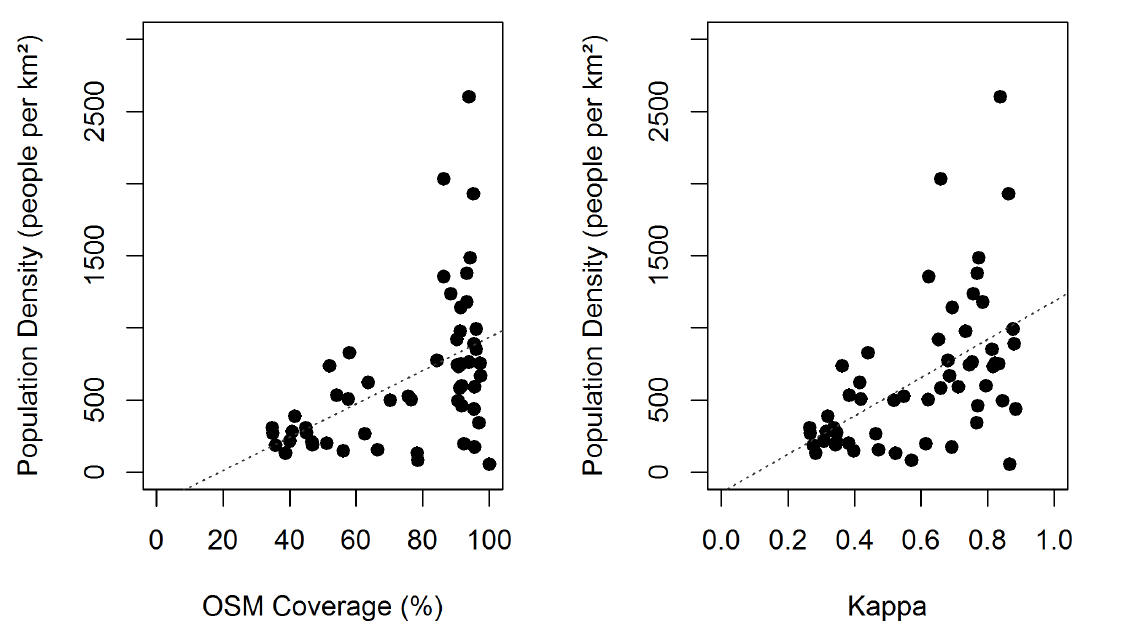
Figure 5. Relation of OSM Coverage (mapped OSM area/municipality area) and kappa to population density for the municipalities in the study area (Population density data © Statistisches Landesamt Baden-Württemberg, Stuttgart,